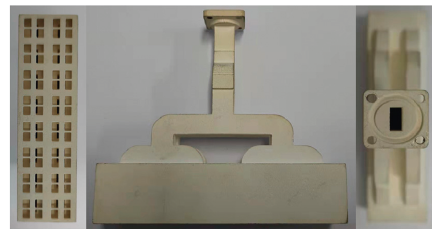
Figure 8: Photograph of the fabricated 2